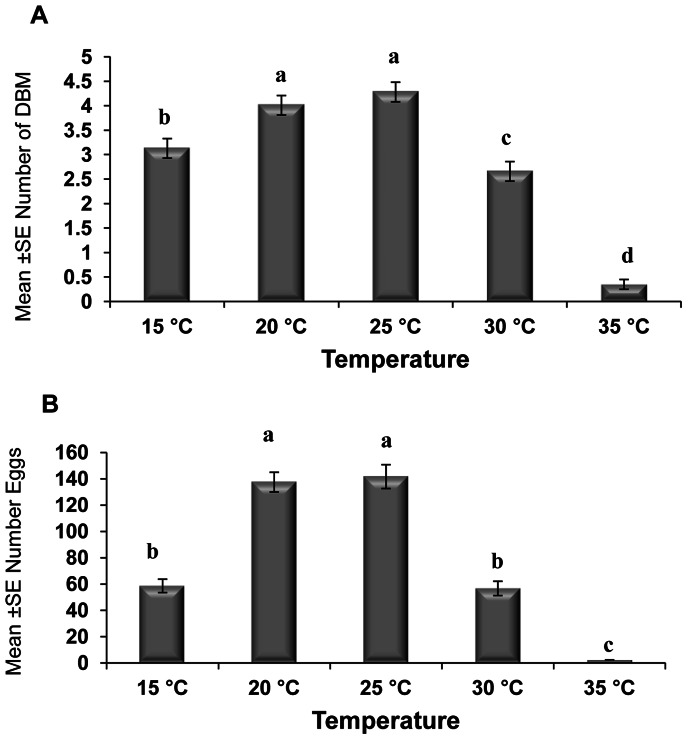
Effect of temperature on adult emergence and egg production.Graph bars represent mean ± SE of number of adults emerged (a), number of eggs produced by DBM adults (b) developed from Nosema infected DBM larvae at 15°, 20°, 25°, 30° and 35°C. Different letters above error bars indicate significant difference (P<0.05).